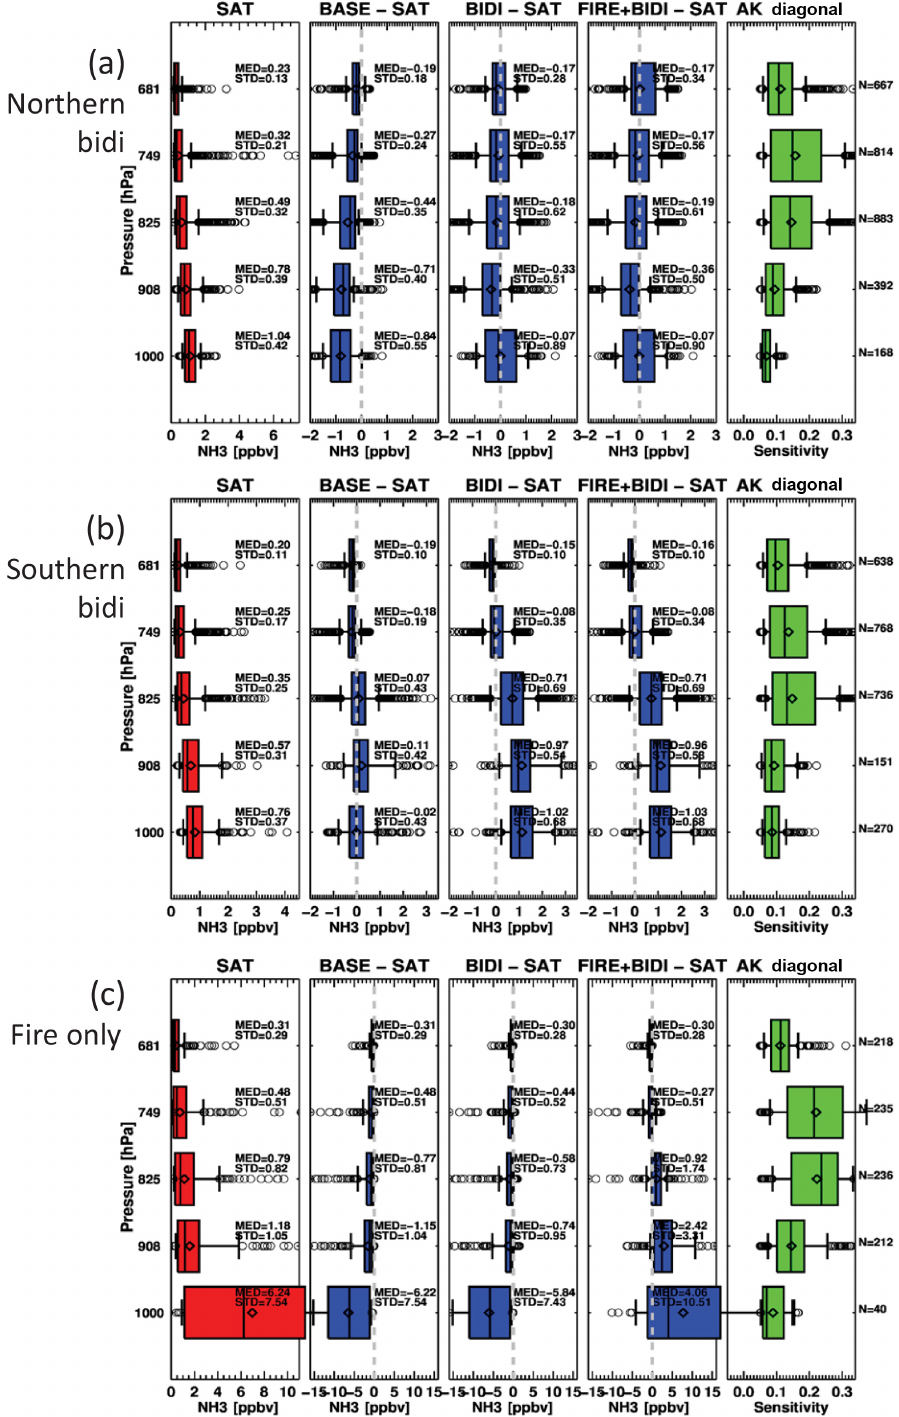
Figure 11. As in Fig. 9a, but for our (a) northern “bidi-only” case study (3 September 2013), (b) southern “bidi-only” case study (1 September 2013), and (c) northern “fire-only” case study (12 August 2013). These regions are shown in Fig. 10a (cyan), 10b (black), and 10c (magenta) boxes,